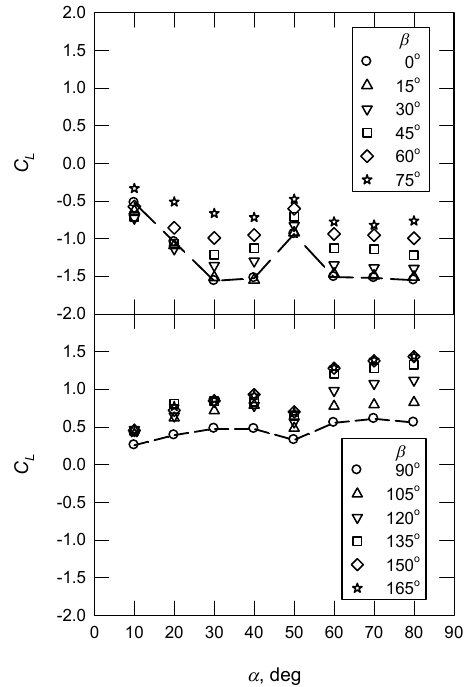
Figure 12. Uplift coefficient.